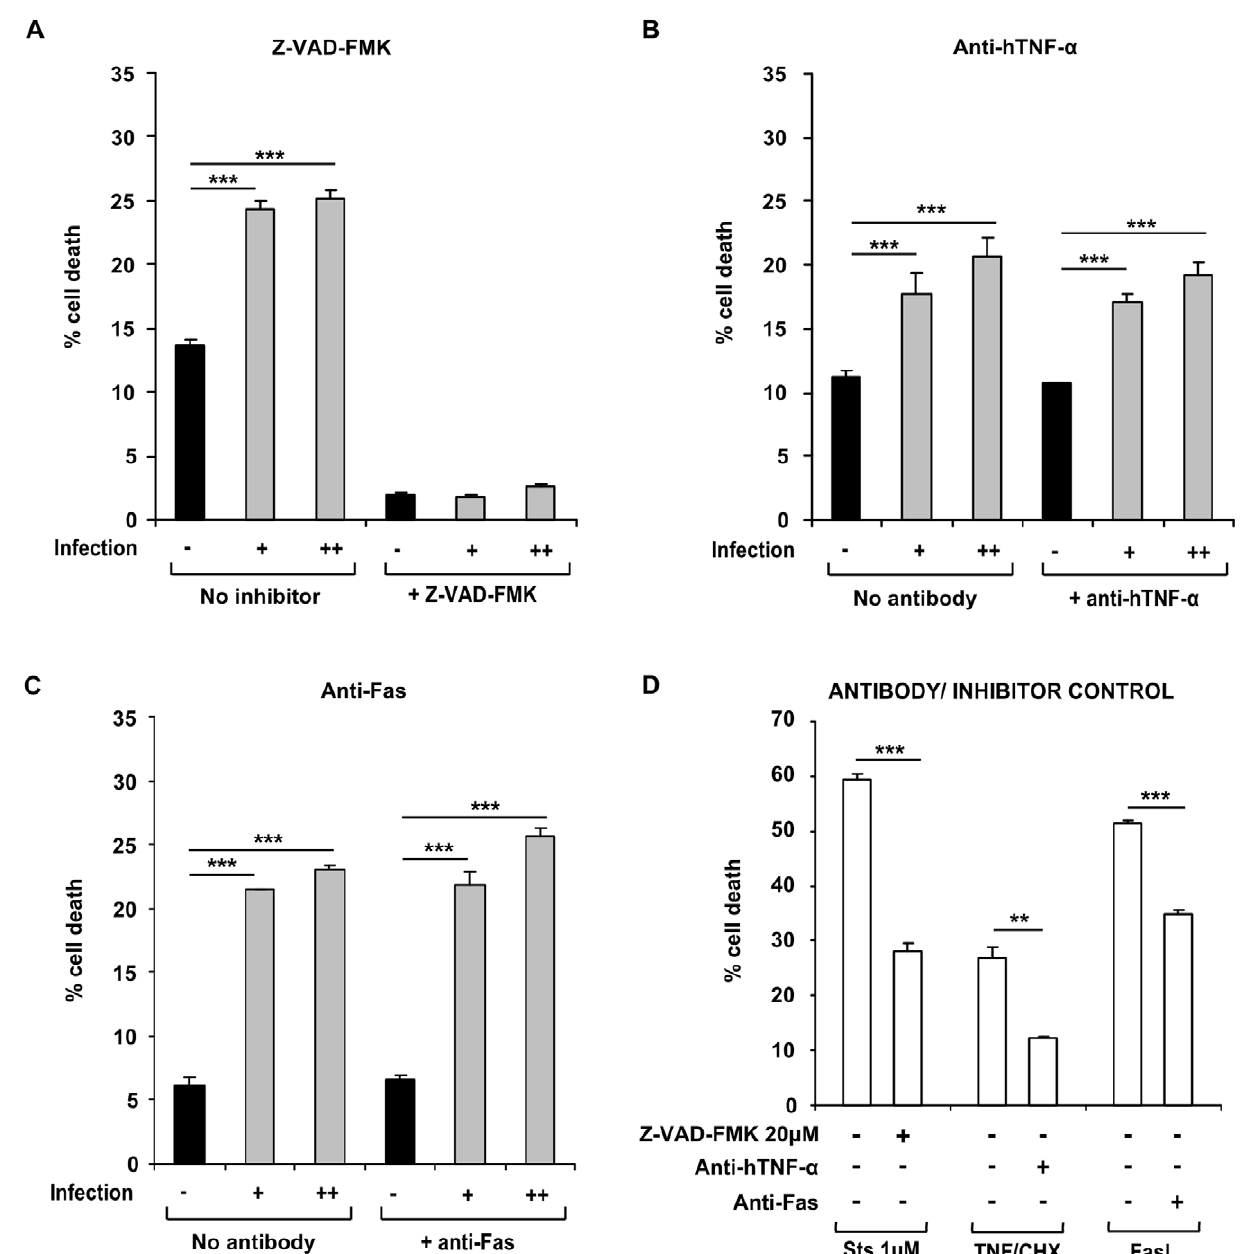
Figure 5. T cell death in M.tuberculosis -infected macrophage supernatants is caspase-dependent, and independent of TNF- a and Fas. (A) Addition of the pan-caspase inhibitor Z-VAD-FMK mitigated cell death induced by low MOI and high MOI-infected macrophage supernatants (shaded bars, infection + and ++ respectively), as well as background cell death observed in the uninfected control supernatants (closed bars, infection -). Cell death in infected supernatants was not mitigated by coincubation with blocking antibodies to TNF- a (B) or Fas (C), and in each case was significantly higher than in uninfected control supernatants (closed bars). Cell death induced by positive controls (D) (1 m M Staurosporine, 5 ng/ ml recombinant human TNF- a + 0.2 m g/ml cycloheximide and 10 ng/ml recombinant human Fas ligand) was in each case significantly reduced by coincubation with the corresponding inhibitor (open bars). Data shown in each panel are from one representative experiment, showing mean percentage cell death 6 SEM from triplicate incubations. **= p , 0.01, ***= p , 0.001, Student’s t test relative to uninfected control (A–C), or positive control relative to inhibitor (D).